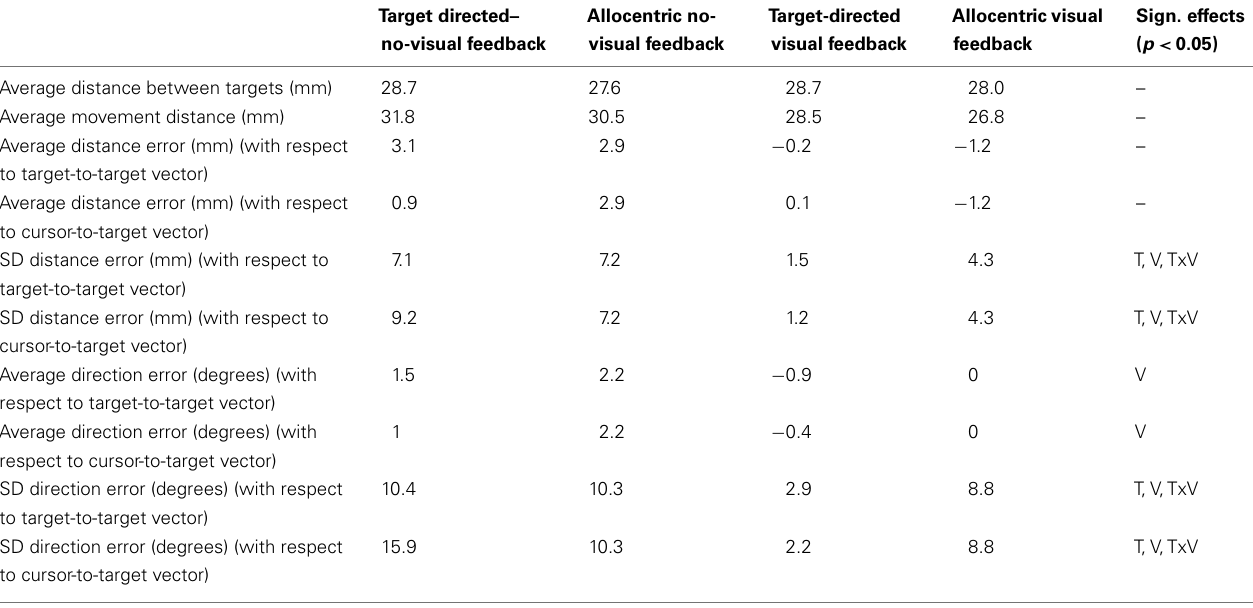
Table 2 | Summary of analysis of hand movement data collected during